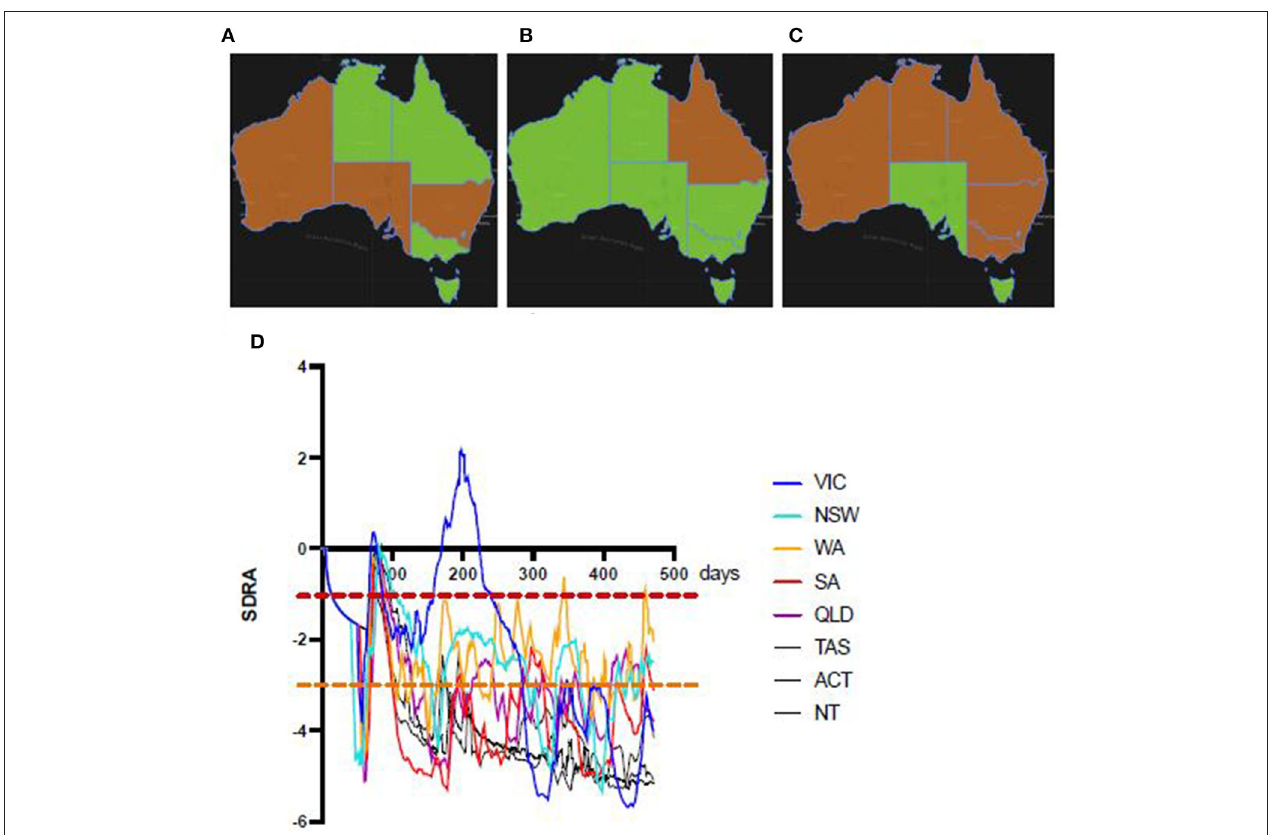
FIGURE 7 | Sequential national snapshots of Australian CRE status. Green (low risk) and orange (medium risk, between lower orange and upper red SDRA thresholds) rating by Australian state and territory on 1st May (left), 1st June (middle) and 1st July (right) show fluctuating CRE status in part due to the recent arrival of the SARS-CoV-2 Delta variant during this period. The corresponding SDRA CRE trend plots by state and territory up to 1st July, 2021 (bottom) show rising CRE baselines in most States and Territories. In New South Wales, Queensland, and Western Australia the CRE (SDRA) had been above the potential propagation threshold for weeks. Noting that the dissemination of the Bondi cluster (NSW) of the Delta variant to other States, the similar pattern to the early stages of the Victorian outbreak suggest a missed opportunity for decisive